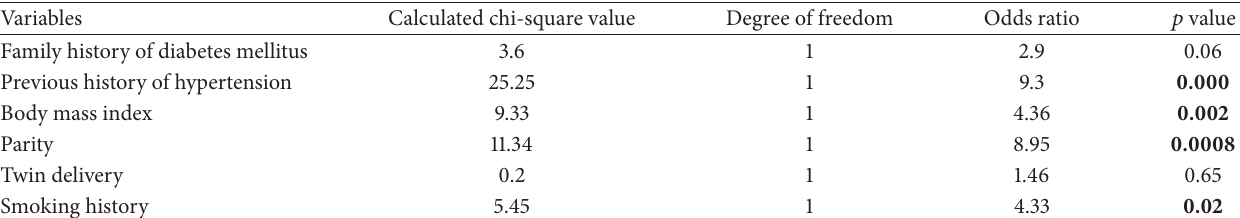
Table 4: Statistical test for associated factors of diabetes mellitus in Debre Berhan Referral Hospital in June